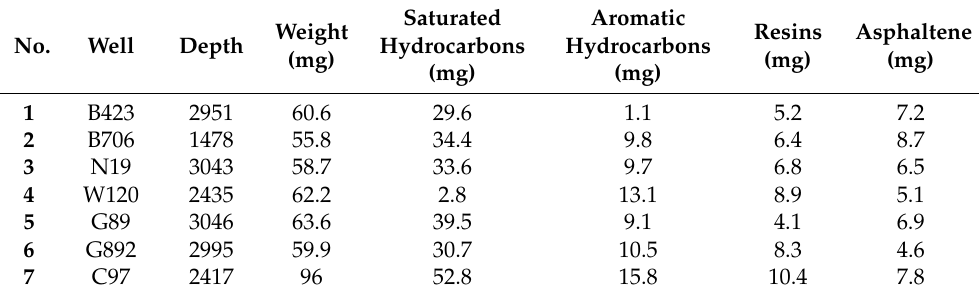
Table 1. Hydrocarbon group composition of tested crude